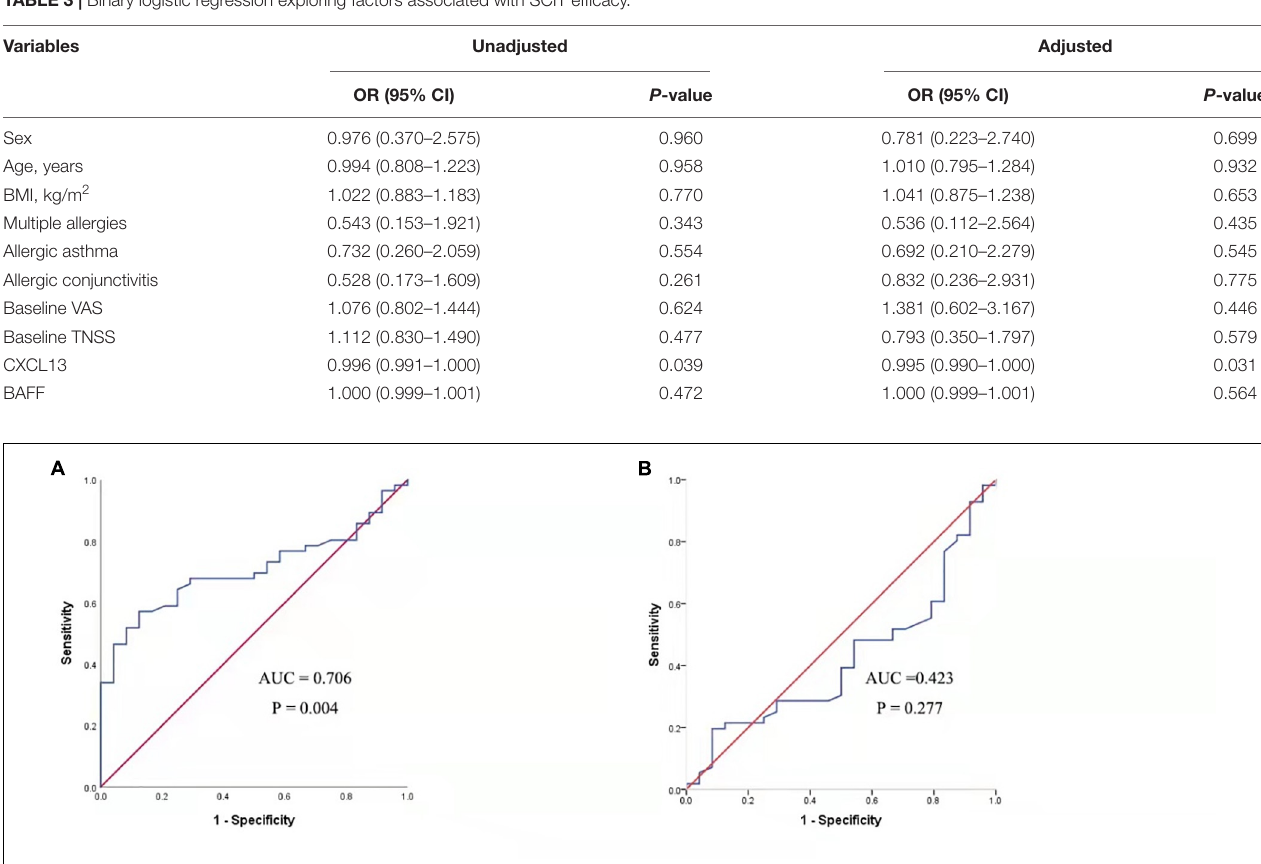
FIGURE 4 | ROC analysis of serum CXCL13 level (A) and BAFF level (B) in predicting the clinical outcome of SCIT in pediatric AR patients. CXCL13, C-X-C motif ligand 13; SCIT, subcutaneous immunotherapy; ROC, receiver operating characteristics; AUC, area under the curve; AR, allergic rhinitis; BAFF, B cell-activating